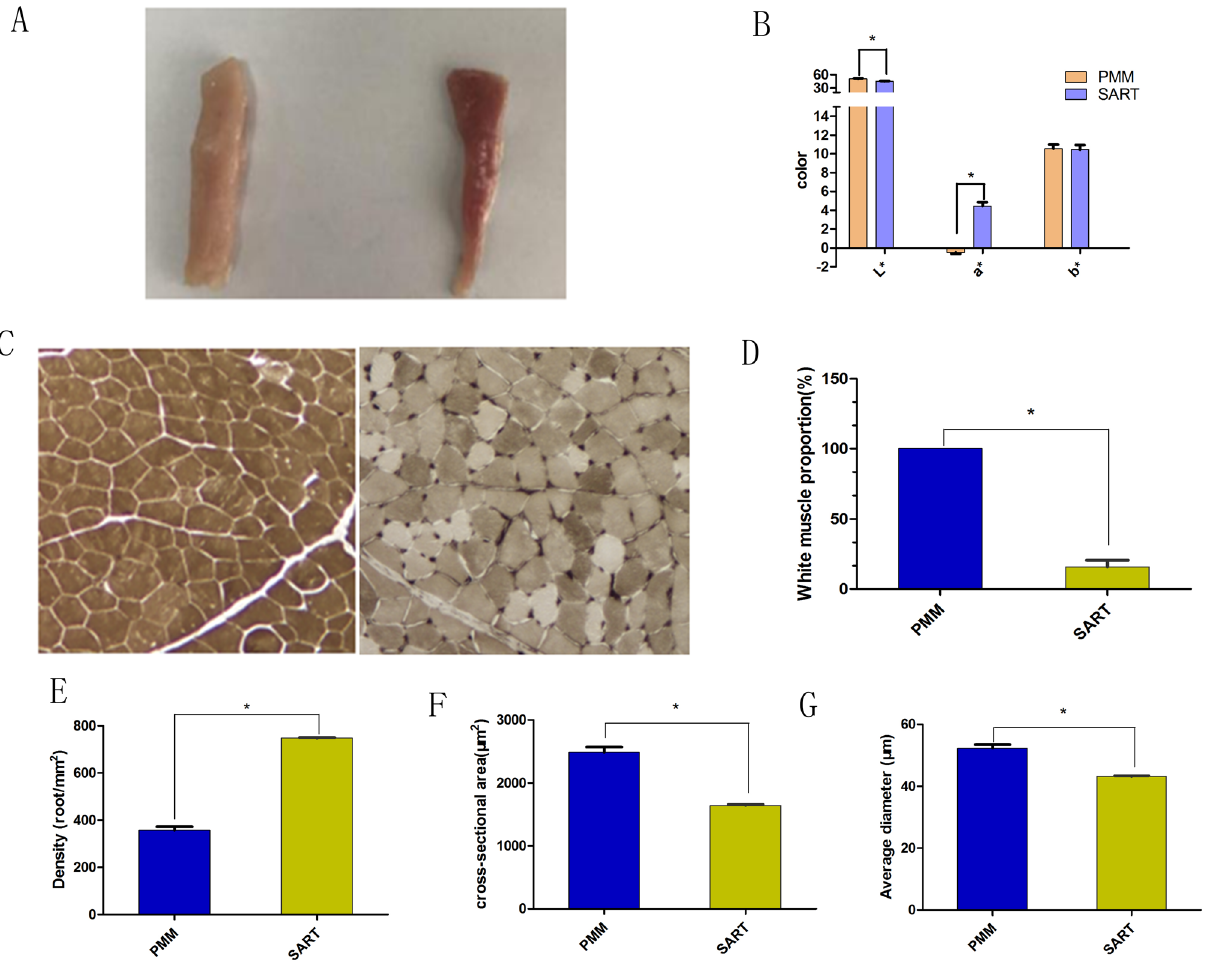
Figure 1. Different phenotypic indices between (pectoralis major) PMM and (sartorius major) SART muscles. ( A ) Fresh samples of PMM and SART, n = 15. Left: PMM, right: SART; ( B ) The color of fresh samples of PMM and SART, n = 15; ( C ) ATPase alkaline incubation staining of muscles in PMM and SART, n = 15. Left: PMM, right: SART; ( D ) The myofiber type ratio (white/red) between PMM and SART, n = 15; ( E – G ) The cross- sectional area, density, and average diameter between PMM and SART, n = 15. Data are means ± SEM. Statistical significance was calculated by Student’s t-test. Significant difference levels: * p < 0.05.